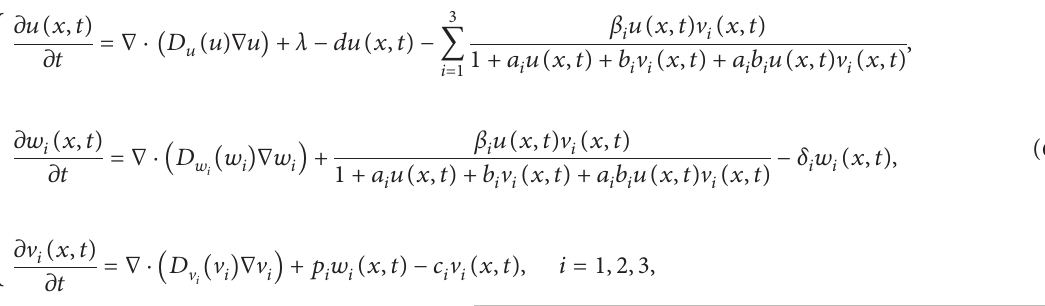
Figure 2: Taking m � m � m � 2, λ � 10, d � 0 . 09, β � 0 . 0025, δ � 0 . 4, c � 2 . 4, p � 300, a � 0 . 0015, and b � 0 . 4, we have R 1 2 3 74 . 4048 > 1 and the infection equilibrium E ∗ � ( 104 . 9054 , 1 . 3963 , 174 . 5354 ) of model (59) is globally asymptotically